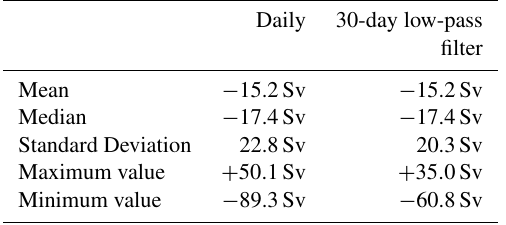
Table 2. Statistics for the volume transport calculated from the PIES and GEM data. The transports were integrated from sites A to D (see Table 1) and from 800 down to 4800dbar (or the bottom, where it is shallower). Statistics were calculated over the period 2009 to 2014 using only the original PIES